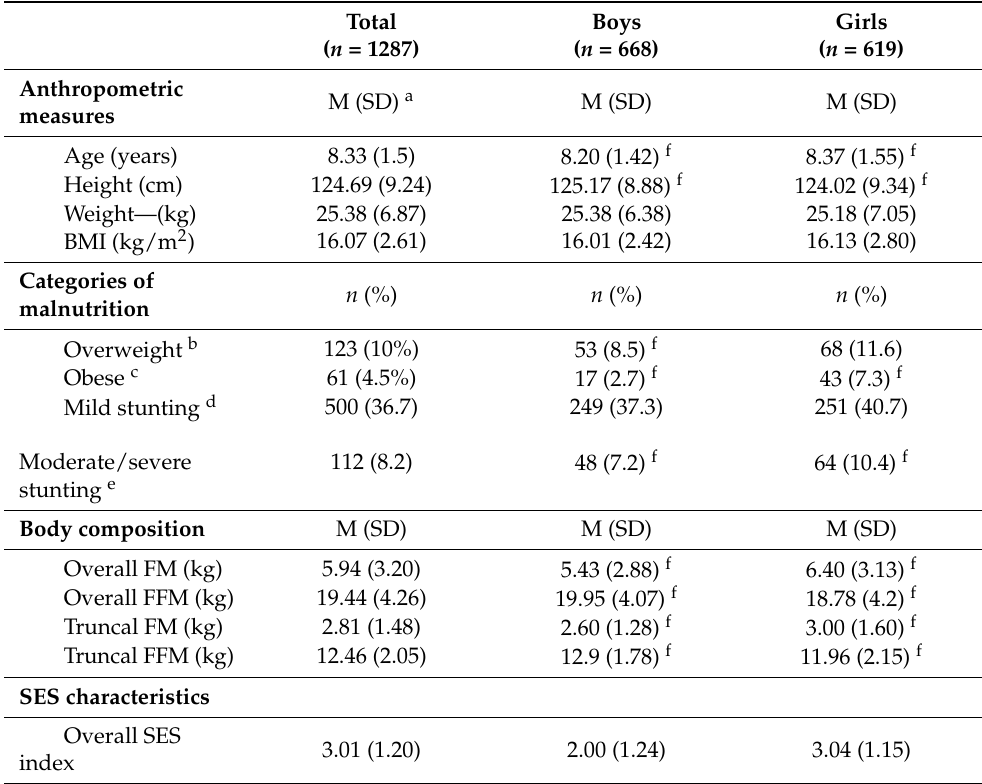
Table 1. Child and household characteristics in the Port Elizabeth, South African component of the KaziAfya